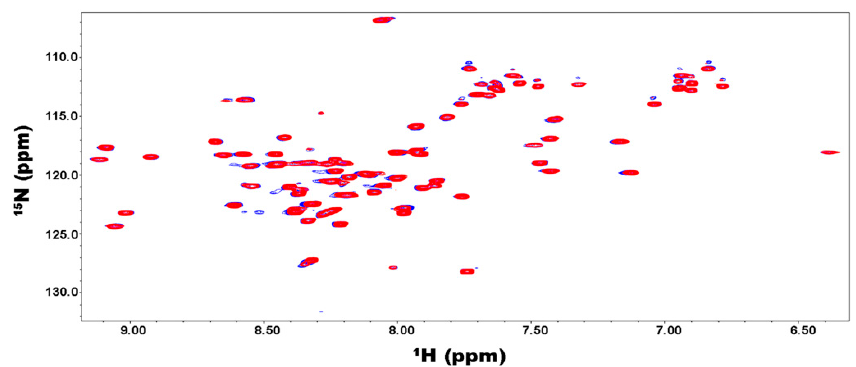
Figure 3. 1 H- 15 N HSQC NMR spectra of Neh1–2LZ1 (100 µ M) in the presence (red) and absence (blue) of 50 mM arginine in 50 mM ammonium acetate buffer, 1 mM DTT, pH 6.5. The spectra were recorded at 25 °C.